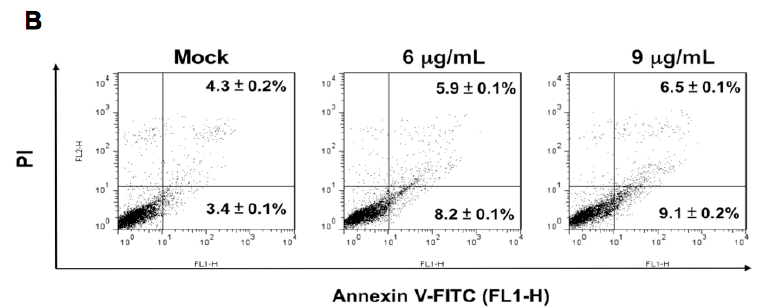
Figure 4. Appearance of apoptotic characteristics in 11- epi -SA-treated HA22T cells. ( A ) Detection of DNA fragments after 11- epi -SA treatment for 24 h at the indicated concentrations. M, marker; C, control; ( B ) Detection of apoptotic HA22T cells after 11- epi -SA treatment by annexin V-fluorescein isothiocyanate (FITC)/propidium iodide (PI) analysis.